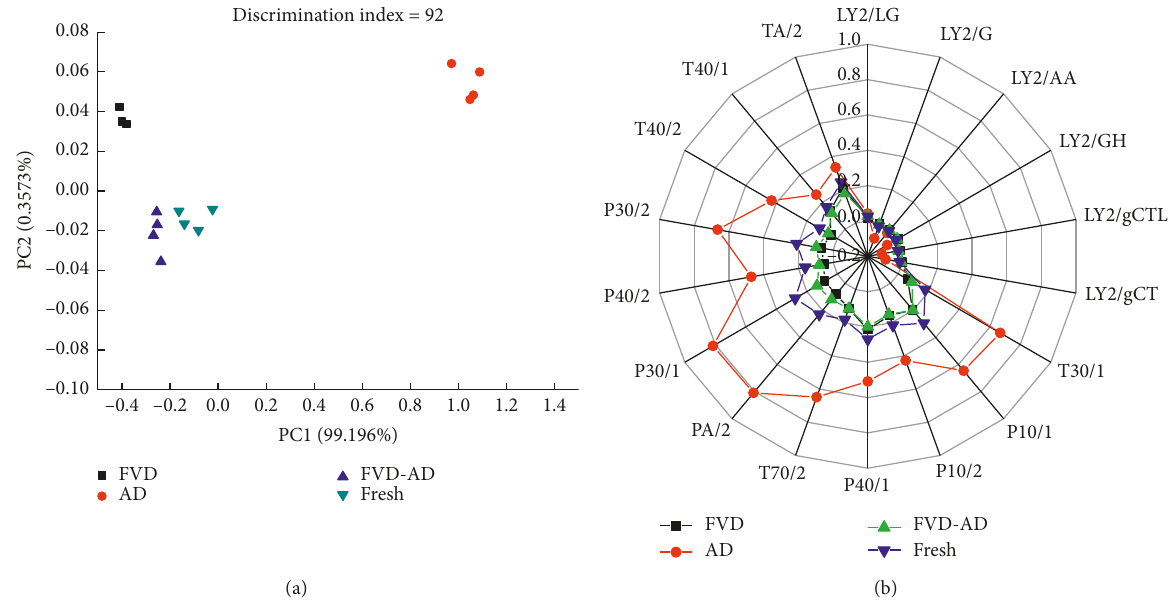
Figure 4: (a) PCA results of kiwifruit samples. (b) Radar map of kiwifruit samples. Note: FVD, freeze vacuum drying; AD, air drying; FVD- AD, combined drying consisting of freeze vacuum drying and air drying. Sensors: 1: LY2/LG; 2: LY2/G; 3: LY2/AA; 4: LY2/GH; 5: LY2/ gCTL; 6: LY2/gCT; 7:T30/1; 8: P10/1; 9: P10/2; 10: P40/1; 11: T70/2; 12: PA/2; 13: P30/1; 14: P40/2; 15: P30/2; 16: T40/2; 17: T40/1; 18: